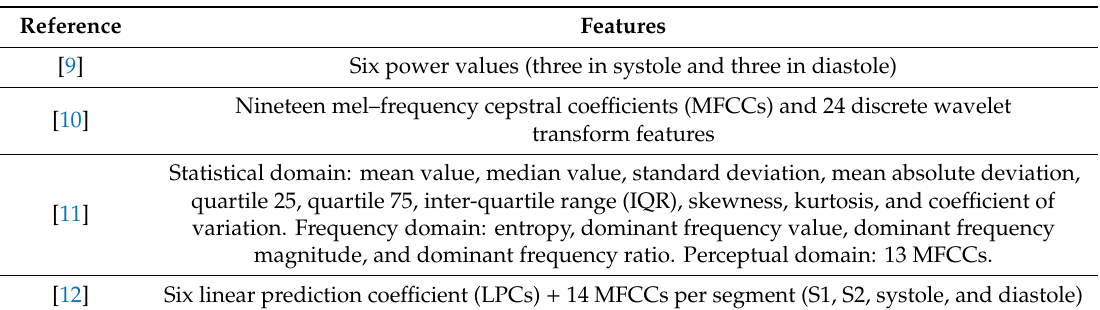
Table 4. Features extracted in models [9–12].